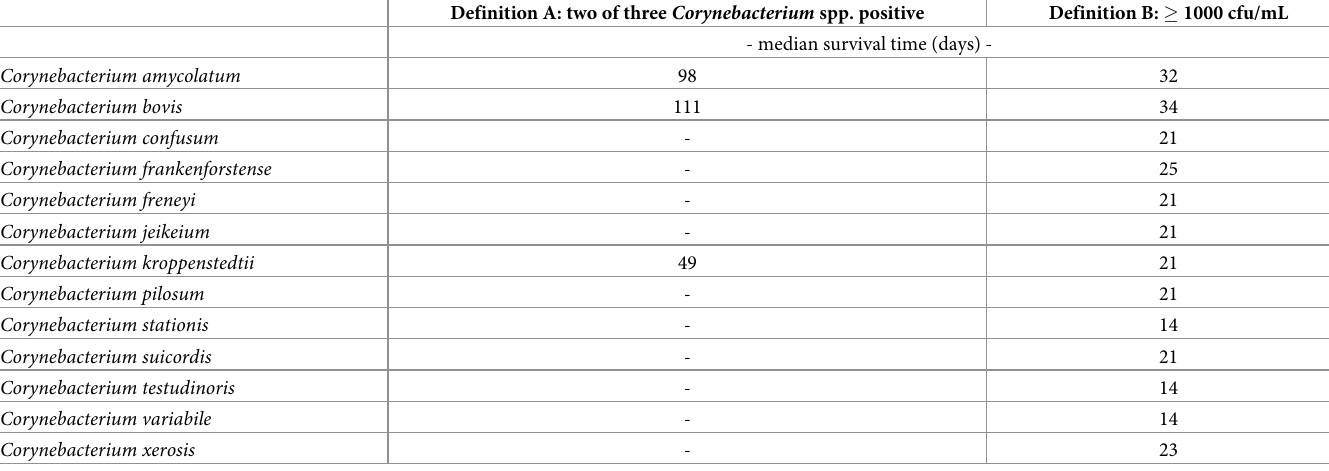
Table 4. Median survival time (Life Tables) of the different Corynebacterium spp. infections.